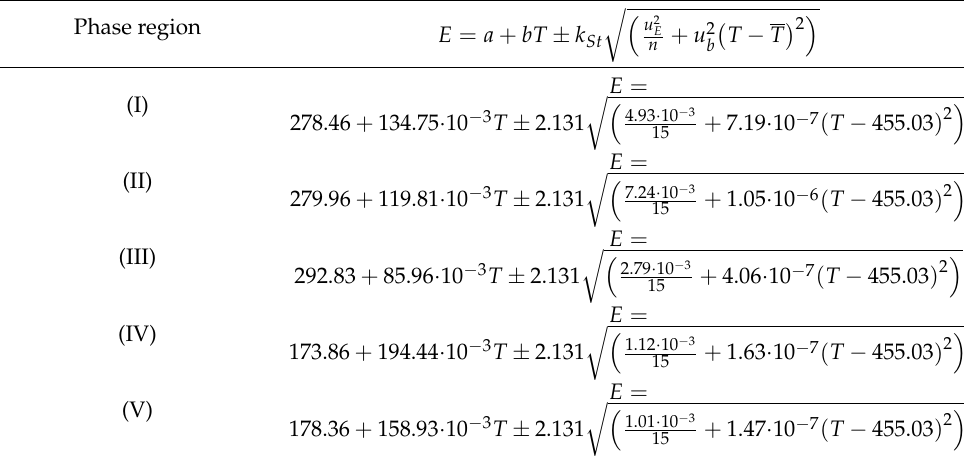
Table 2. The E vs. T dependences for the type (A) GCs in the (I)–(V) phase regions of the Ag–In–Te system in the range between 420 and 489 K.